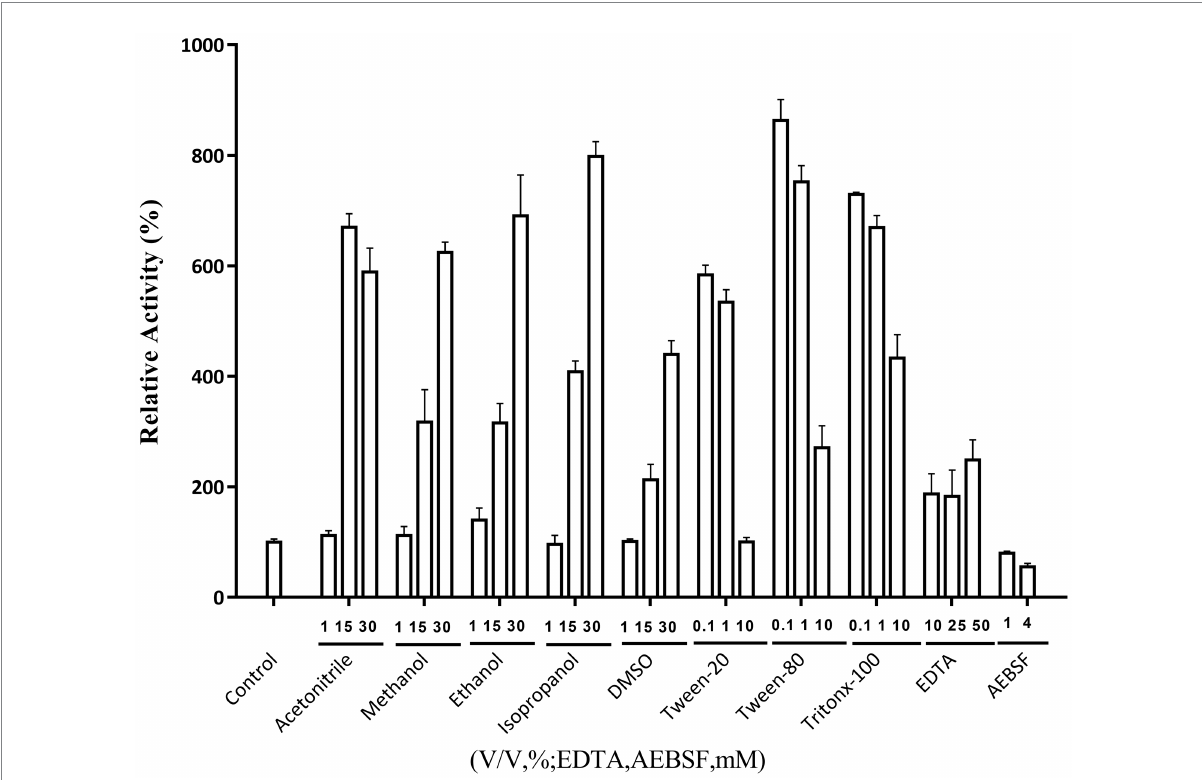
FIGURE 4 Effects of several organic solvents, surfactants, and two chemical reagents on recombinant Lip54q activities. At the optimal reaction temperature and pH of Lip54q, different final concentrations (10, 25, and 50 mM) of organic solvents (acetonitrile, methanol, ethanol, isopropanol, and DMSO), different final concentrations (0.1, 1, and 10%, v/v) of the surfactants (Tween-20, Tween-80, and Triton X-100), different final concentrations (10, 25, and 50 mM) of EDTA, and two final concentrations (1 and 4 mM) of serine protease inhibitor, AEBSF, were added to the enzymatic reaction system to determine their effects on the enzymatic activities of Lip54q. All tests were repeated three times, and the enzymatic activity of an enzymatic reaction system without the above target reagents was defined as